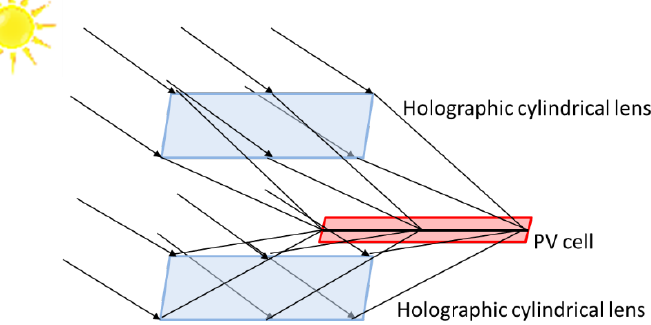
Figure 6. Schematic of the system considered: each cylindrical holographic lens redirects sun rays towards a PV cell [48].